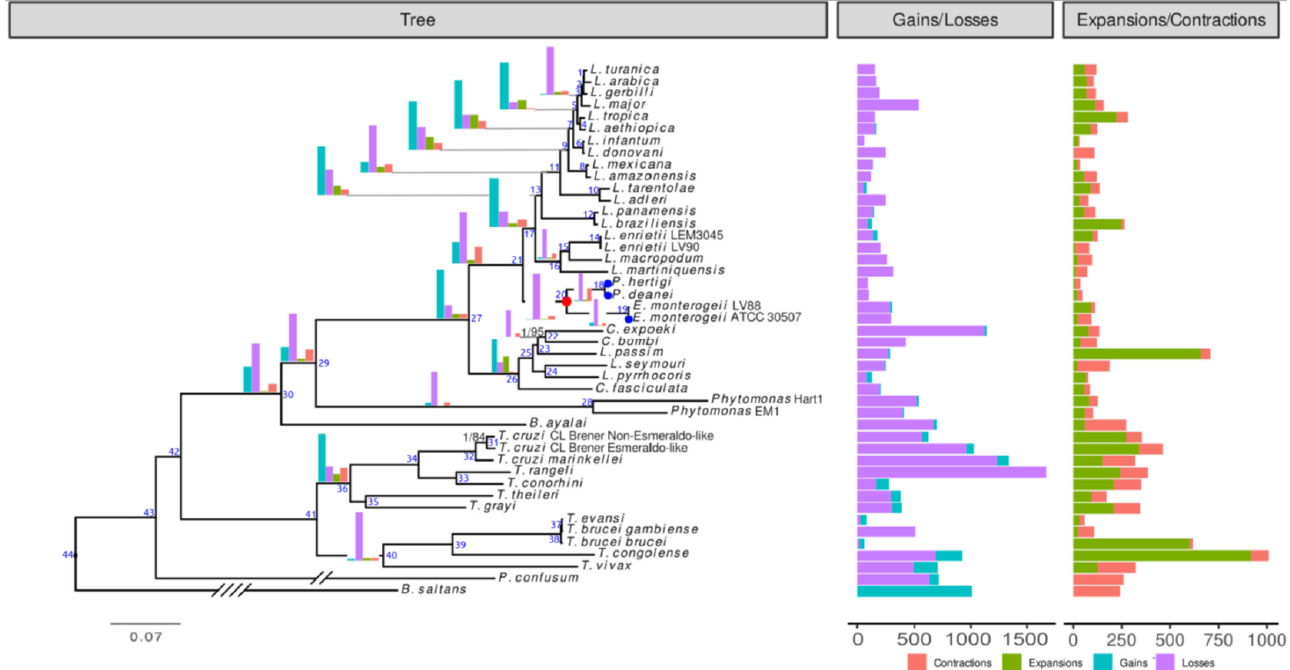
Figure 1. Phylogenomic tree based on 410 proteins encoded by single-copy genes from 44 trypanosomatids and the eubodonid Bodo saltans, Posterior probabilities and bootstrap supports are shown (in black) only if the latter is <100%. The scale bar represents substitutions per site. The numbers of orthologous groups (OG) gained/lost/expanded/contracted at certain nodes and leaves (species) are depicted using bar plots placed at the nodes and on the right of the tree, respectively (see Table S8 for exact counts; node numbers indicated in blue correspond to those in the Table S8). The Endotrypanum / Porcisia node (node 20) and the isolates sequenced in this study are marked with red and blue circles, respectively. The length of B. saltans and P. confusum branches was reduced four- and two-fold, respectively, for visualization purposes.